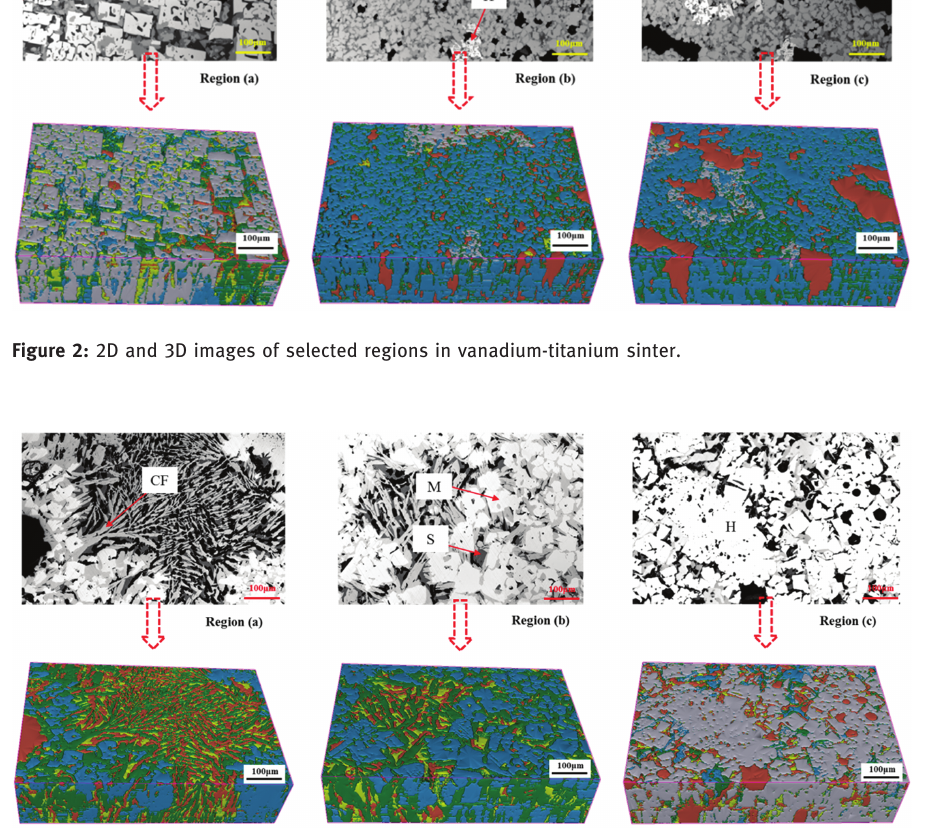
Figure 3: 2D and 3D images of selected regions in traditional